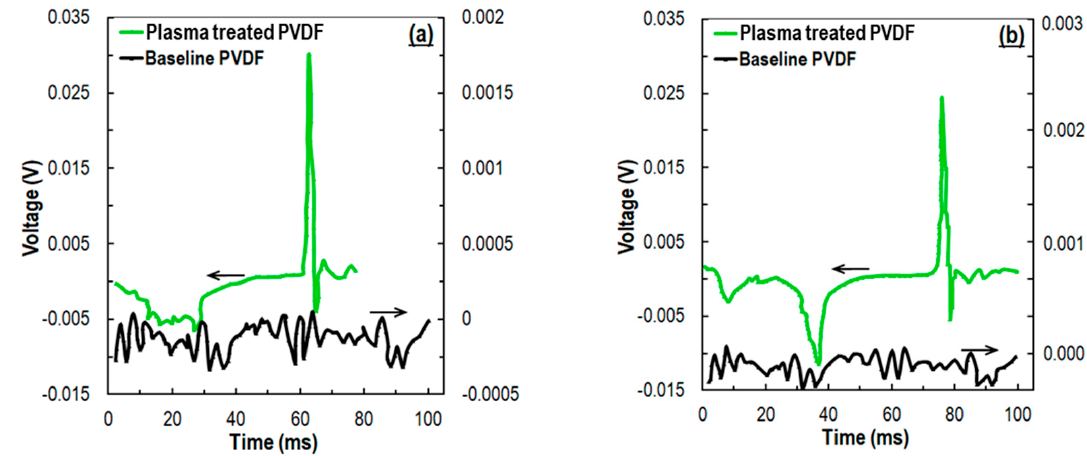
Figure 7. Average of 10 experiments with ( a ) big impactor ¾” (0.28 N) ( b ) small impactor ½” (0.01 N).